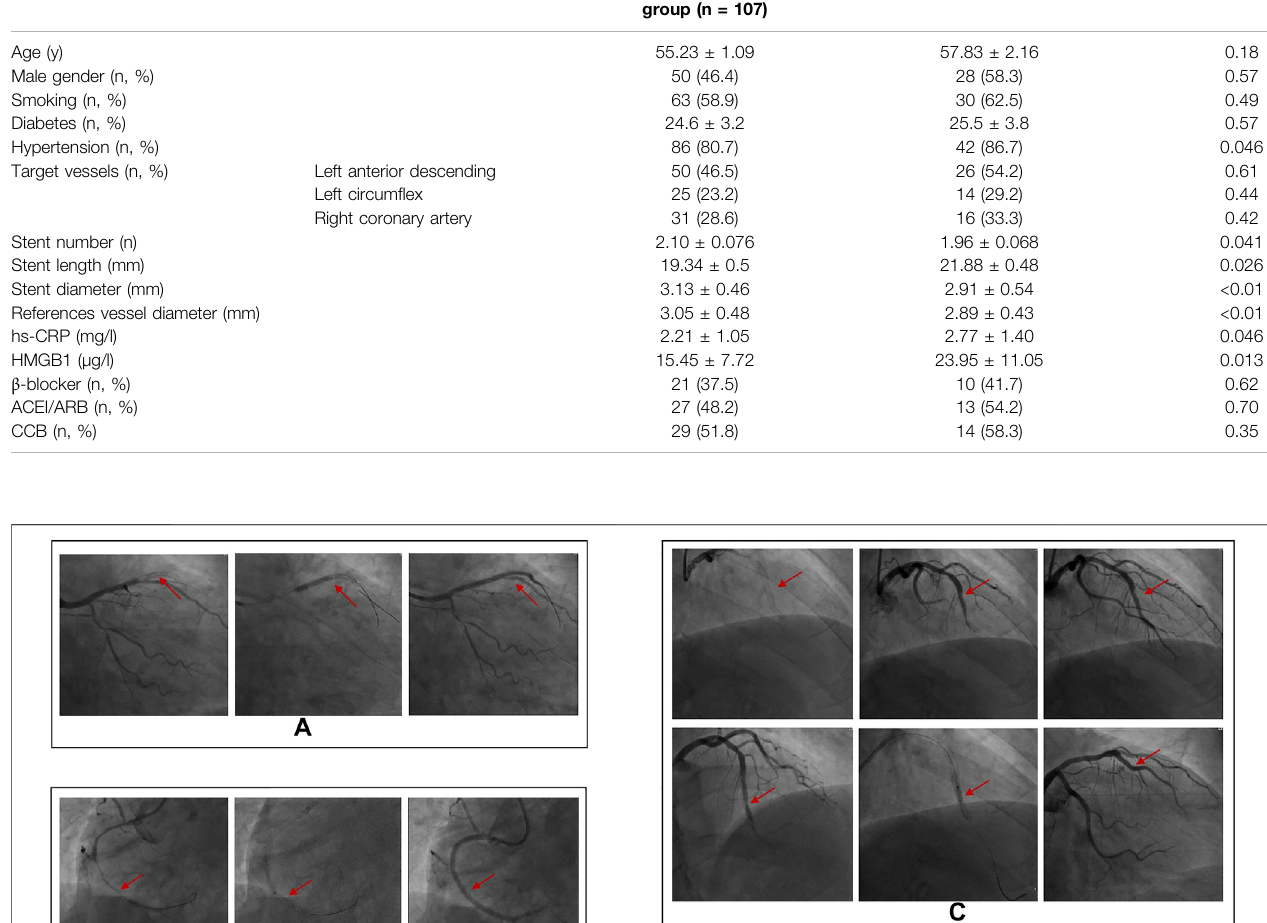
Frontiers in Pharmacology |